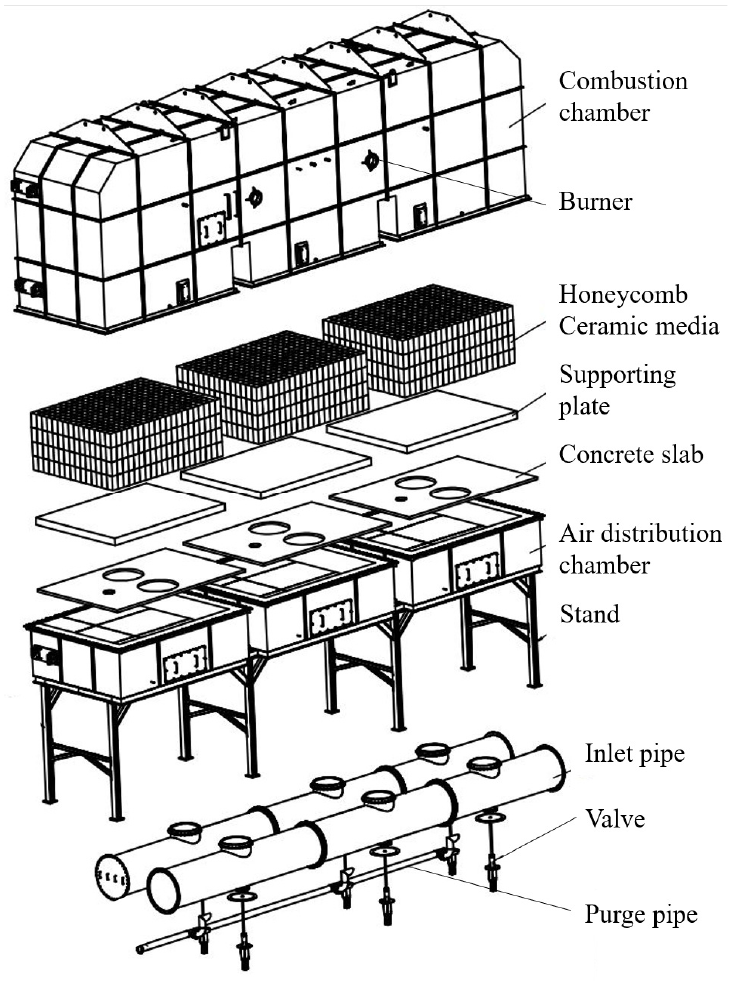
Figure 1. Structure of a three-canister RTO. Table 2. Specifications of the RTO.